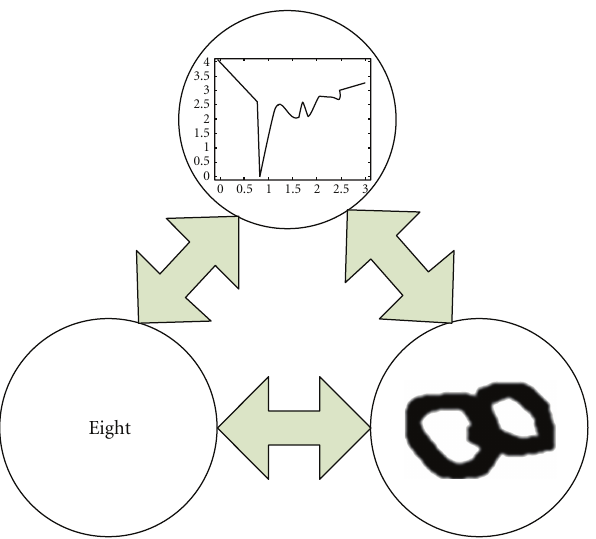
Figure 15: Labeled Behavior